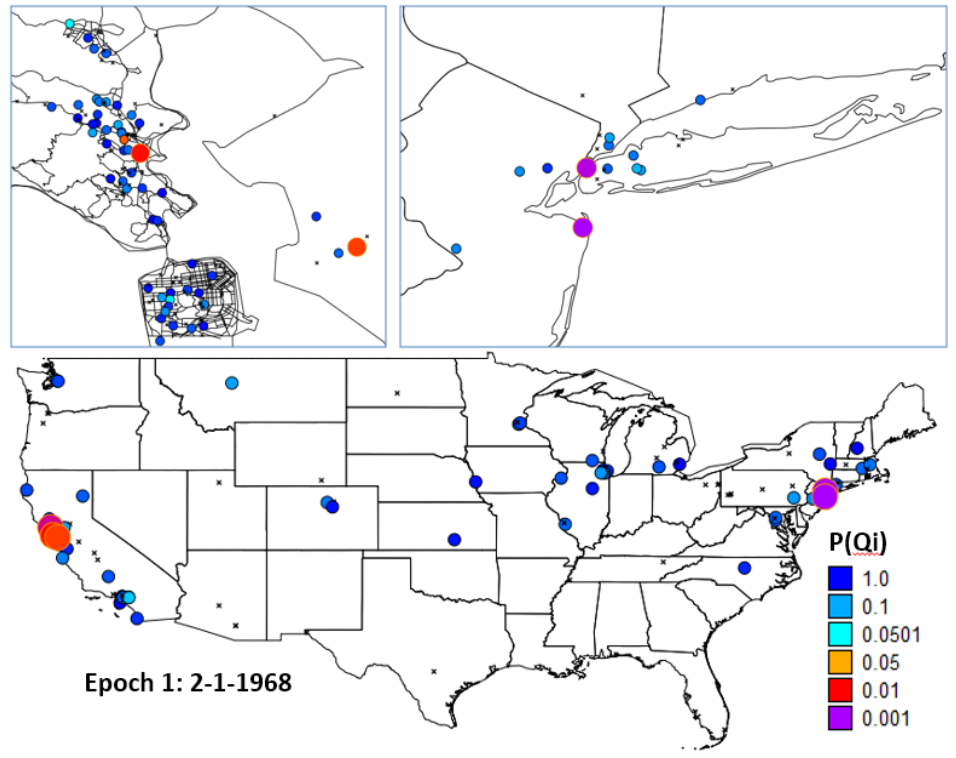
Figure 7. Life course clusters in Epoch 1. Locations of cases with significant clustering over their life course at the end of Epoch 1. Five cases had residential history data recorded on 2-1-1968. One case with significant clustering resided in Marin County ( upper left ), two were in the Bay area ( bottom ), and two in the Northeast near Long Island ( upper right